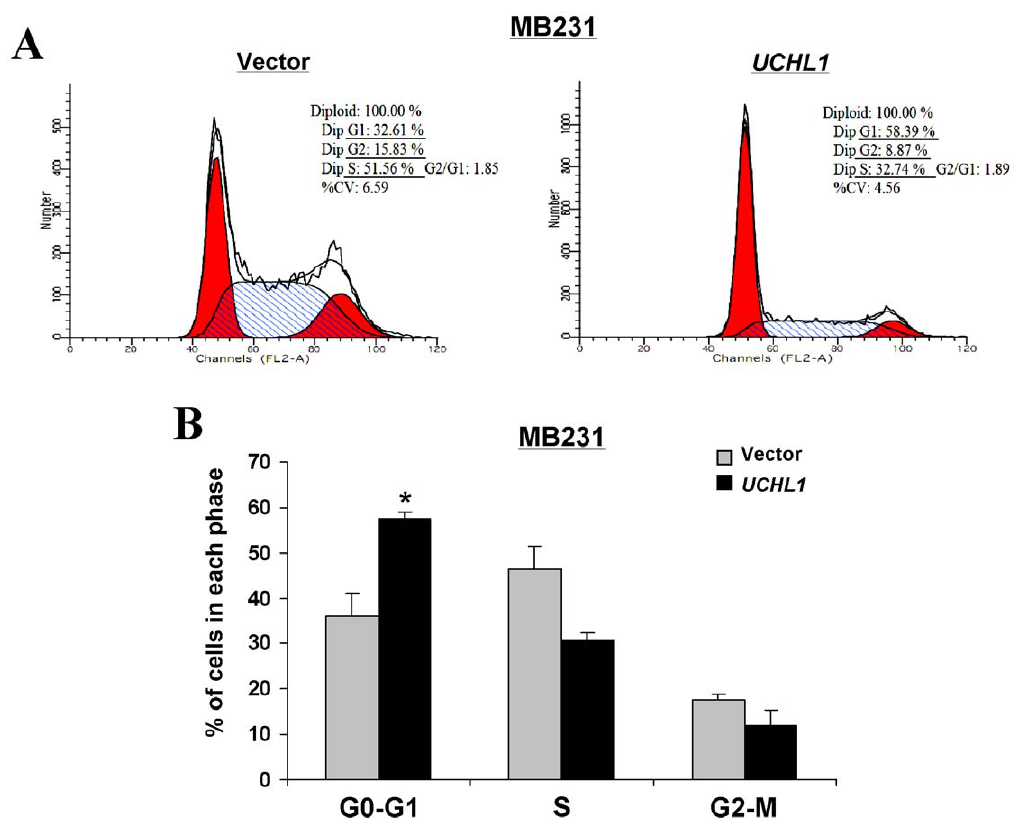
Figure 5. Effect of UCHL1 on cell cycle distribution of MB231 cells. (A) Representative cell cycle analysis. (B) Summarized flow cytometry data. Results are represented as average 6 S.D and are based on three independent experiments. Statistical significance was determined using Student’s t- test (p , 0.001).